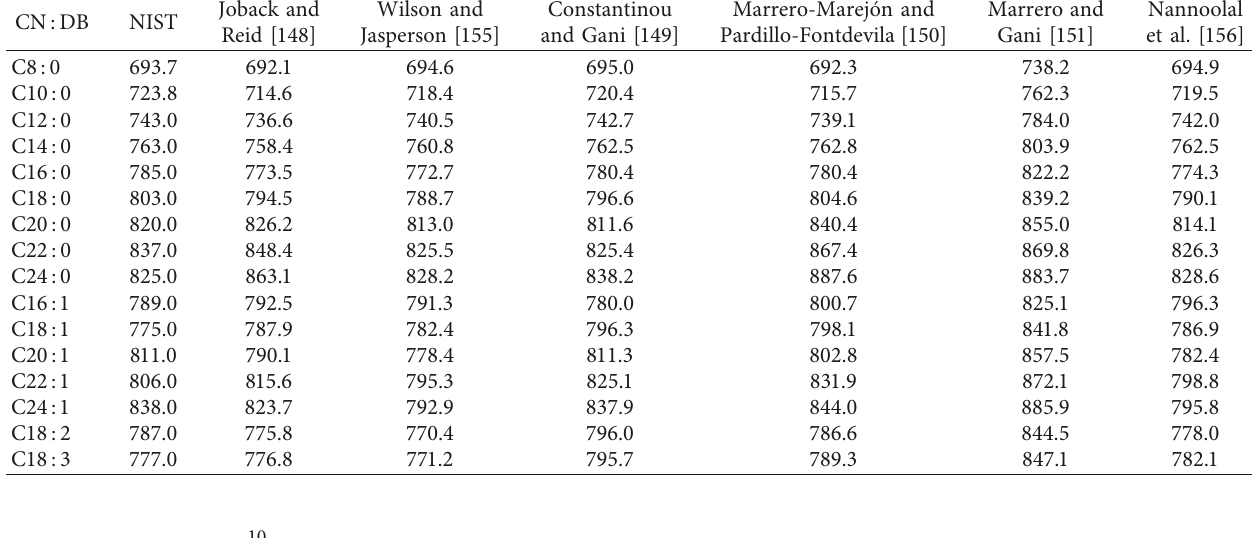
Table 12: Comparison of experimental and estimated critical temperature (K).